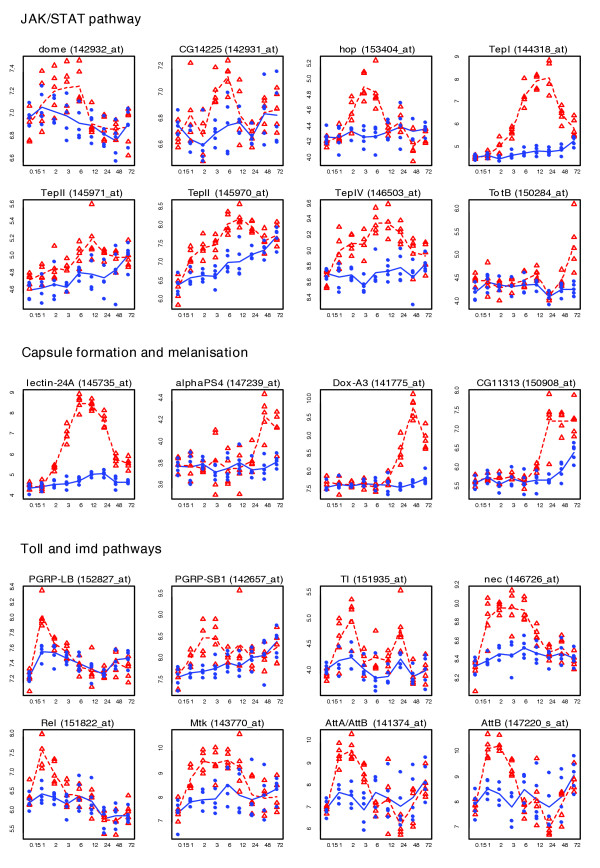
Expression profiles of genes from pathways and processes known to be involved in immunity. Each graph depicts the log2 expression values for a single gene at different time points (in hours) after parasitoid attack. The blue circles and red triangles show the individual replicates of the control and parasitized larvae, respectively. The lines denote the average expression at each time point. See text for a discussion of the selected genes.